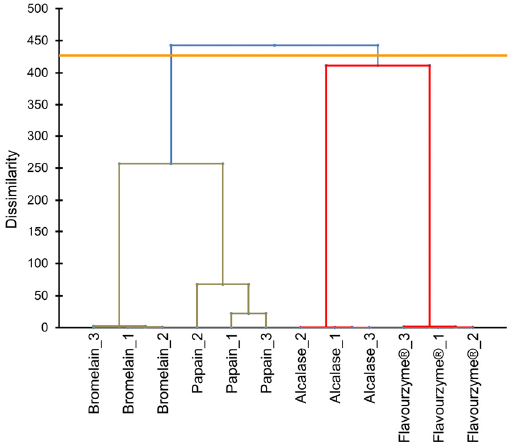
Figure 1. Cluster analysis using the unweighted pair group method with arithmetic mean (UPGMA) dendrogram based on peptides quantifications provided by the action of alcalase, bromelain, papain, and flavouryme ® on pork liver.